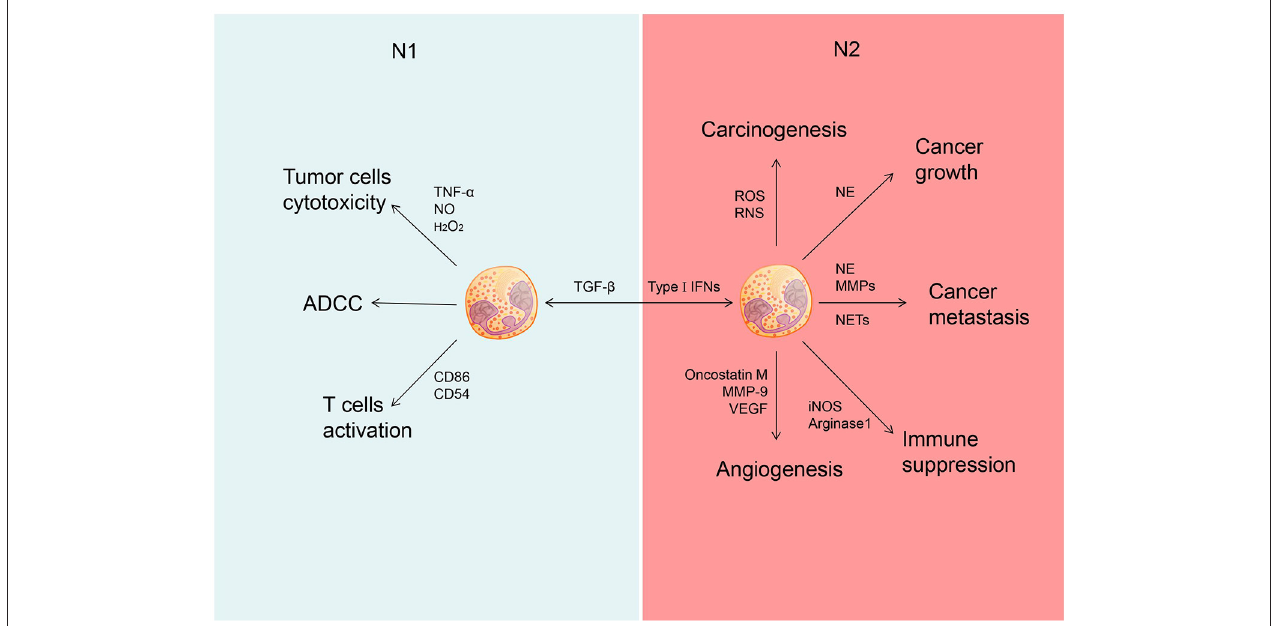
FIGURE 1 | Different role of N1 and N2 neutrophils in cancer. Neutrophils could be polarized into N1 phenotype under the induction of TGF-â and polarized into N2 phenotype under the induction of type I IFNs. N1 neutrophils could inhibit the development of cancer through tumor cells cytotoxicity, ADCC and activate T cells. N2 neutrophils could promote the development of cancer through promoting carcinogenesis, tumor growth, cancer metastasis, and cancer angiogenesis as well as suppress